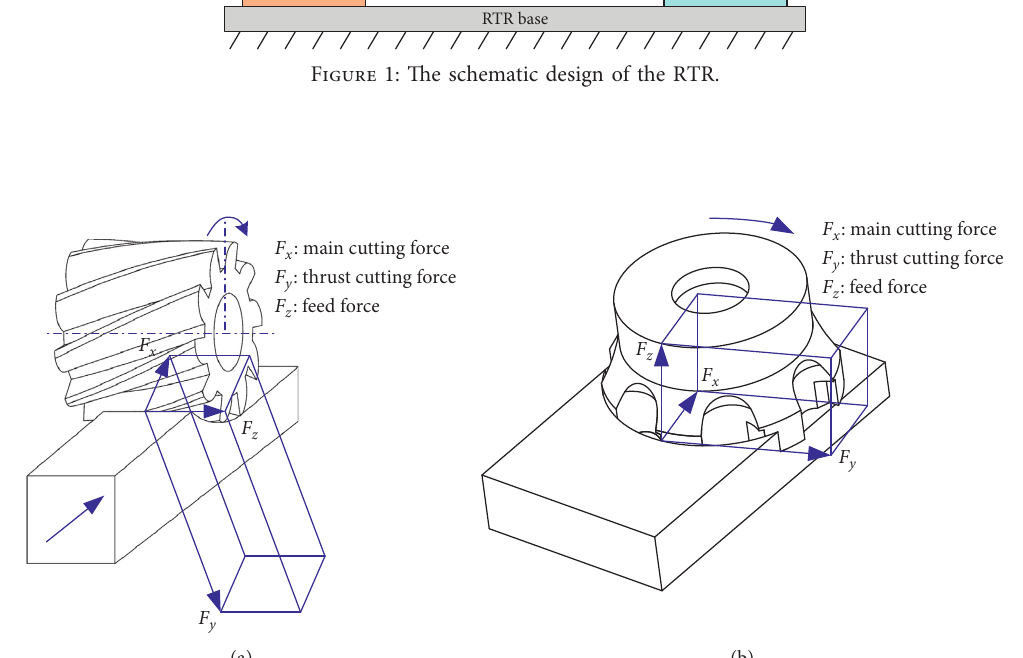
Figure 2: Load analyses of the milling spindle. (a) Peripheral milling. (b) Face milling.